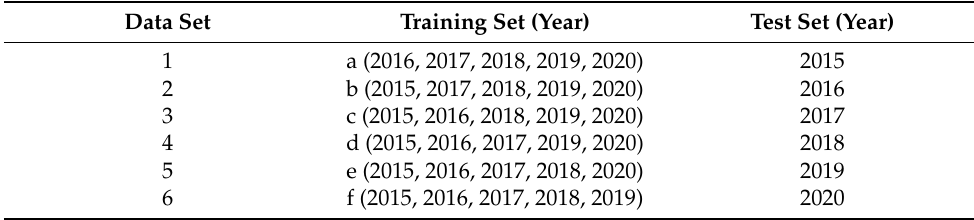
Table 3. Dataset